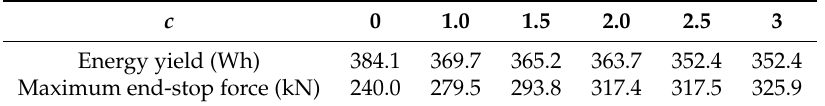
Table 5. Simulated energy yield and maximum force in connection line during 80 s for different c